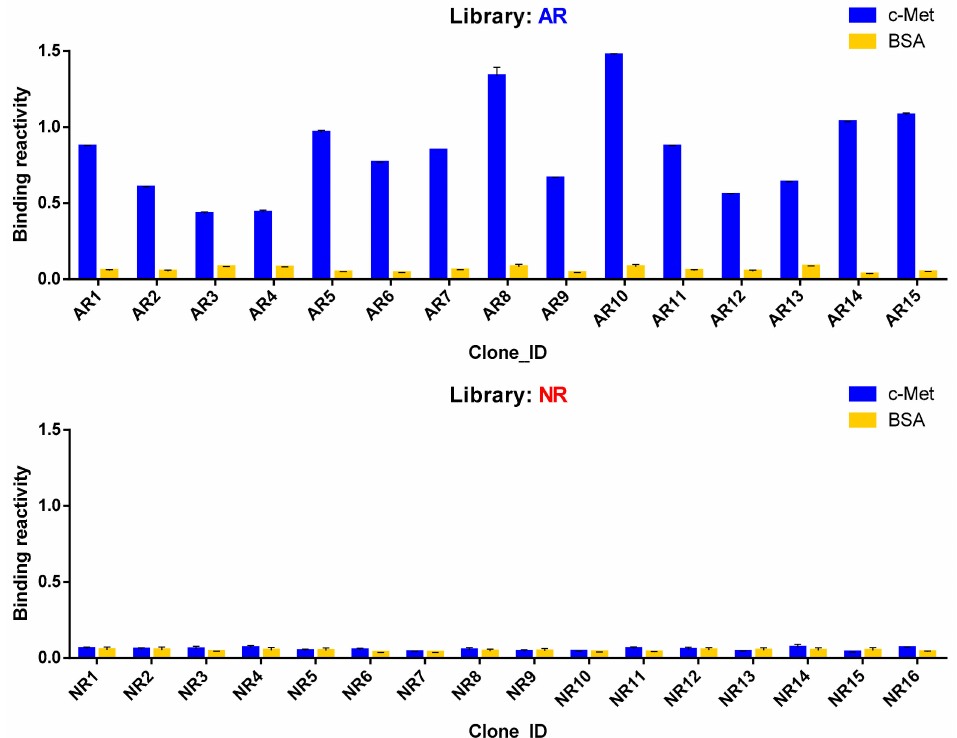
Figure 4. Reactivity of phage-displayed scFv clones in phage ELISA. Binding reactivity of 15 unique clones identified from the AR library and 16 unique clones from the NR library are shown. Wells in microtiter plates were either coated with recombinant mouse c-Met or just blocked with 3% BSA in PBS. Phage clones, HRP-conjugated anti-M13 antibody, and HRP substrate solution were added sequentially with intermittent